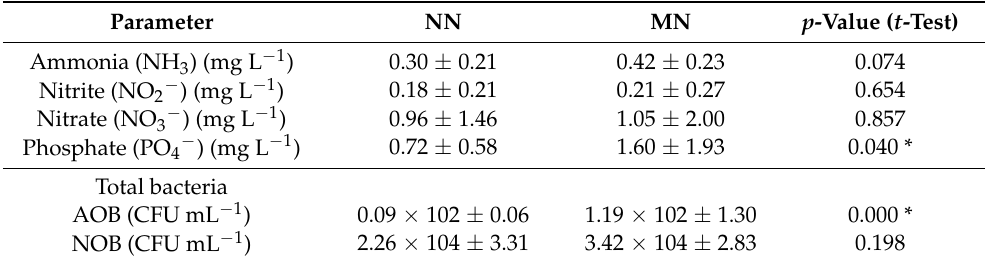
Table 1. Chemical and microbial loads in an integrated aquaponic culture system.